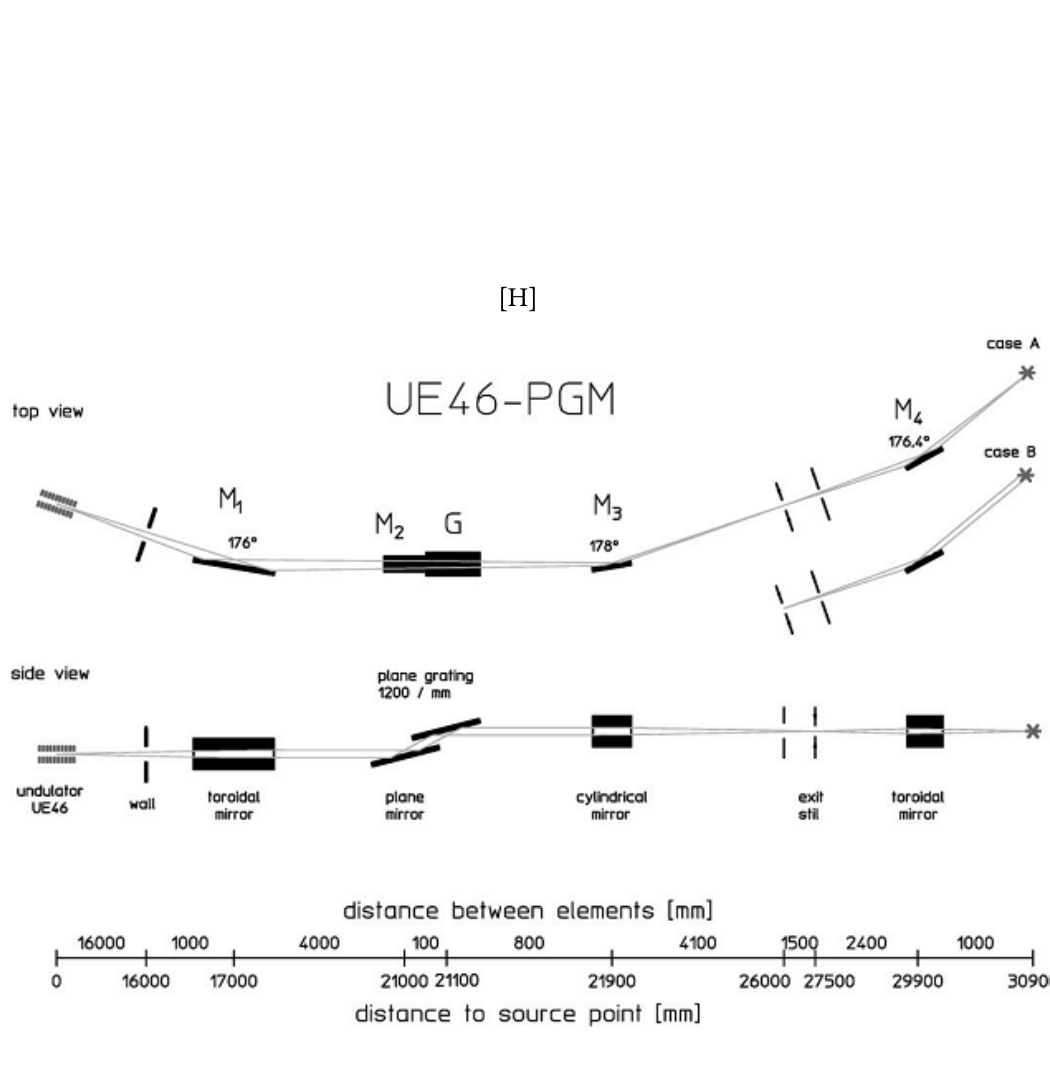
Figure 1: Optical layout of the beamline UE46 PGM-1 (Reprinted from Nuclear Instruments and Meth- ods in Physics Research Section A: Accelerators, Spectrometers, Detectors and Associated Equipment, Volumes 467–468, Part 1, Englisch et al. (2001): The elliptical undulator UE46 and its monochromator beam-line for structural research on nanomagnets at BESSY-II page 544, Copyright (2017) with permis- sion from